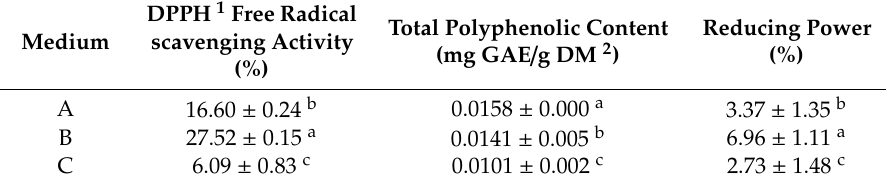
Table 1. Antioxidant activities of S. aureus Newman strain isolated from di ff erent modifications of the Mueller-Hinton agar: non-supplemented (control medium A); supplemented with 1% ( v / v ) Tween 80 (medium B); supplemented with 1% ( v / v ) Tween 80 and trans -anethole at subinhibitory concentration—MIC 50 (medium